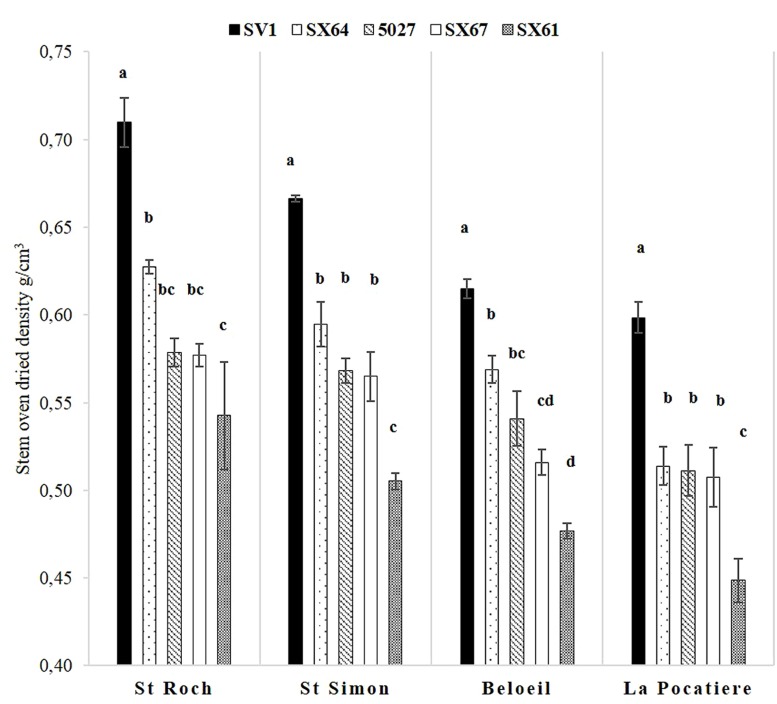
Stem density was assessed using oven dried specific gravity (grams per cubic centimeters) from five willow cultivars in their second year of a harvest cycle (Salix viminalis 5027, S. dasyclados SV1, S. miyabeana SX61, S. miyabeana SX64, S. miyabeana SX67) sampled at four field trials in Québec: Saint-Roch-de-l′Achigan, Beloeil, S-S and LP. Error bars represent standard error, n = 4 blocks (four trees per block). Tukey’s HSD pairwise post hoc test (α = 0.05) are represented by letters a–d.